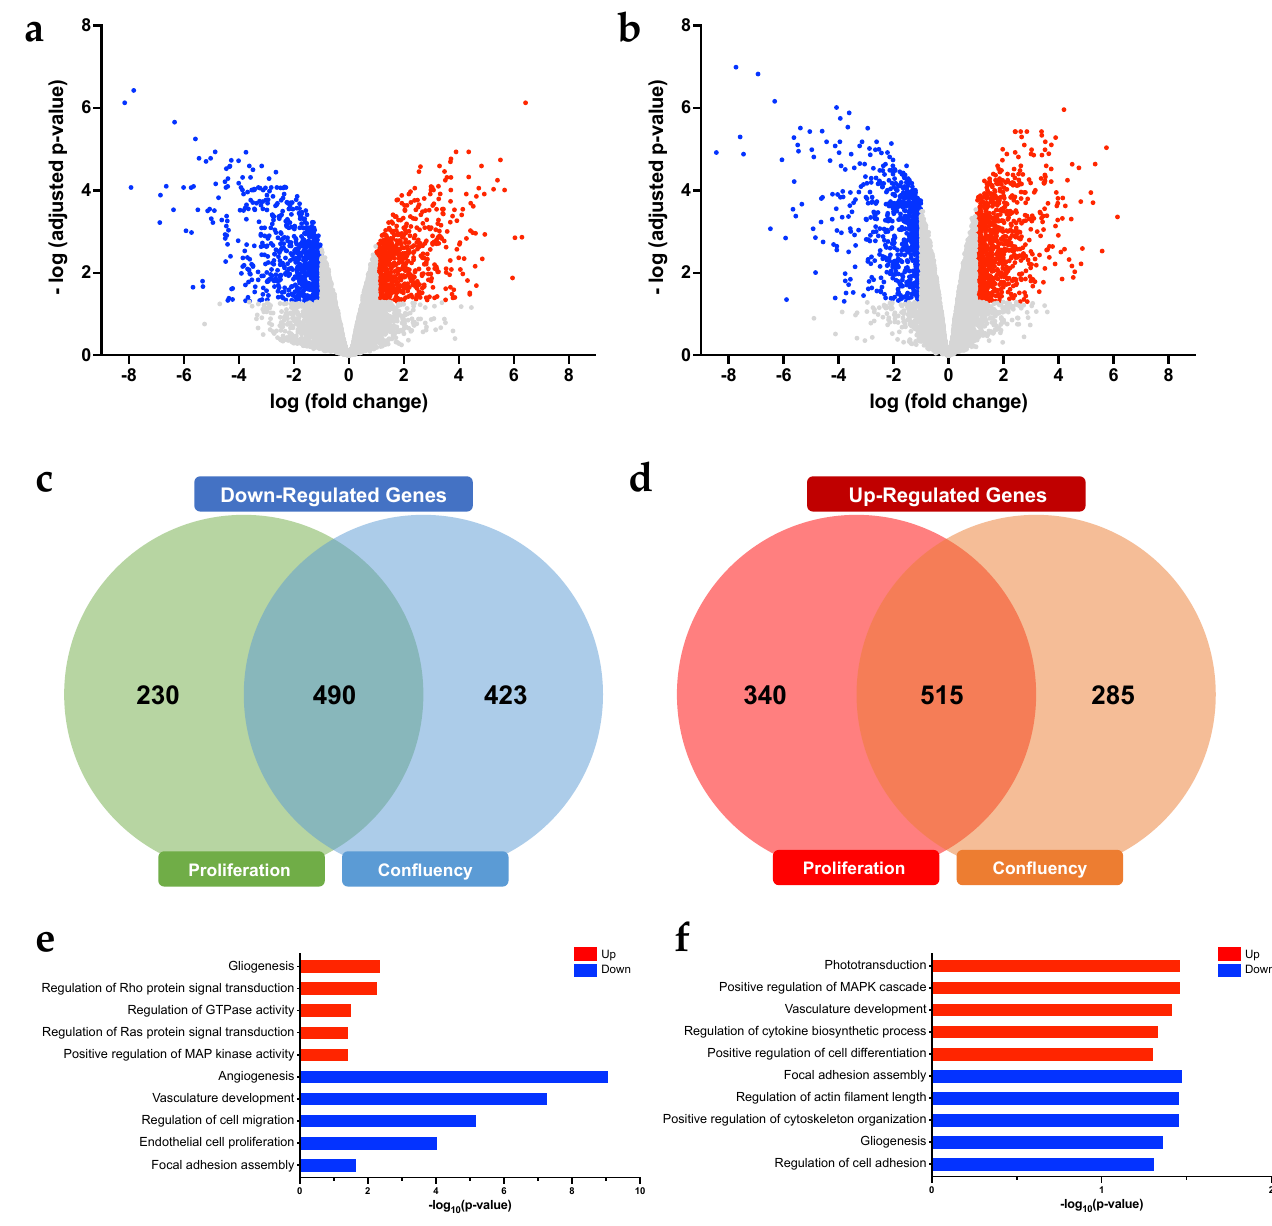
Figure 3. Determination of differentially modulated genes and enriched biological processes in proliferative and confluent RNF213-deficient hCMEC/D3. Volcano plots showing the DEGs in RNF213 knockout endothelial cells cultured in proliferation ( a ) or at confluency ( b ). Venn diagrams of significantly down-regulated ( c ) and up-regulated genes ( d ) in function of the cellular state of RNF213 knockout endothelial cells. Enriched GO terms of biological processes of interest regulated in proliferative ( e ) or confluent ( f ) RNF213-deficient hCMEC/D3. Investigations were all performed using the Network Analyst platform. Significantly enriched GO terms are shown with Benjamini- Hochberg FDR-corrected adjusted p -values. n =